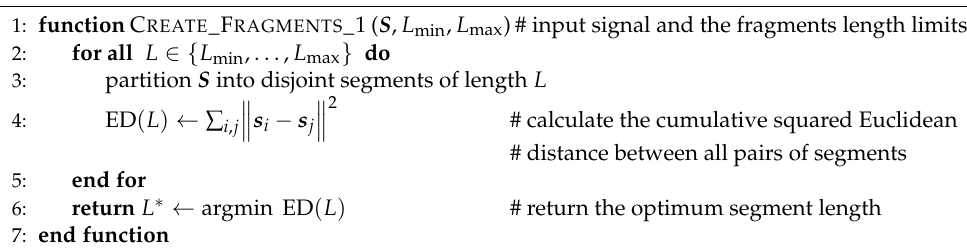
Algorithm 1 The signal fragmentation yielding equal size